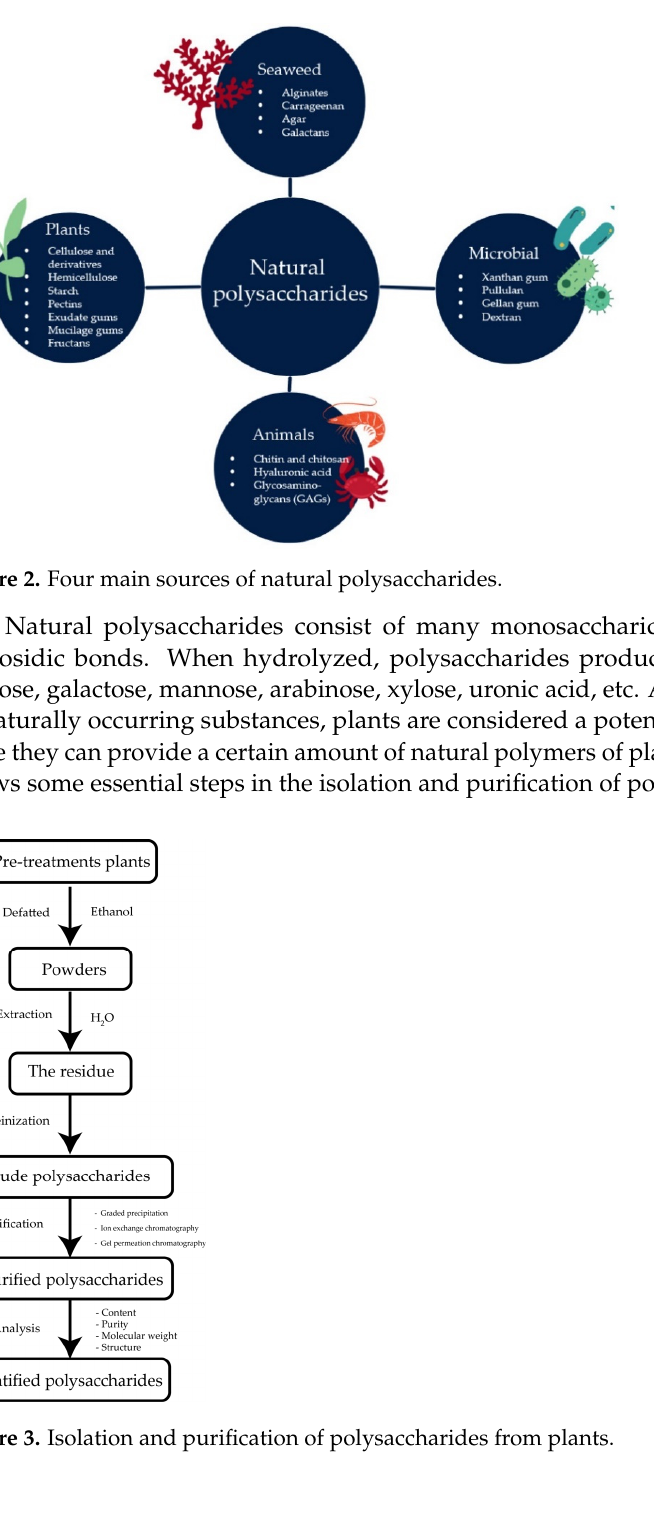
Figure 1. Flowchart of the inclusion and exclusion criteria for review articles.